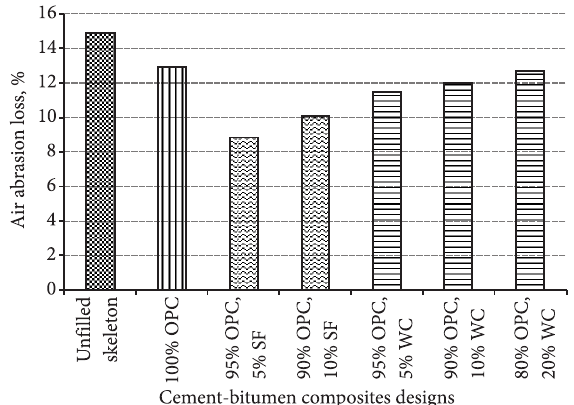
Fig. 5. Resistance to abrasion performance for different cement- bitumen composites